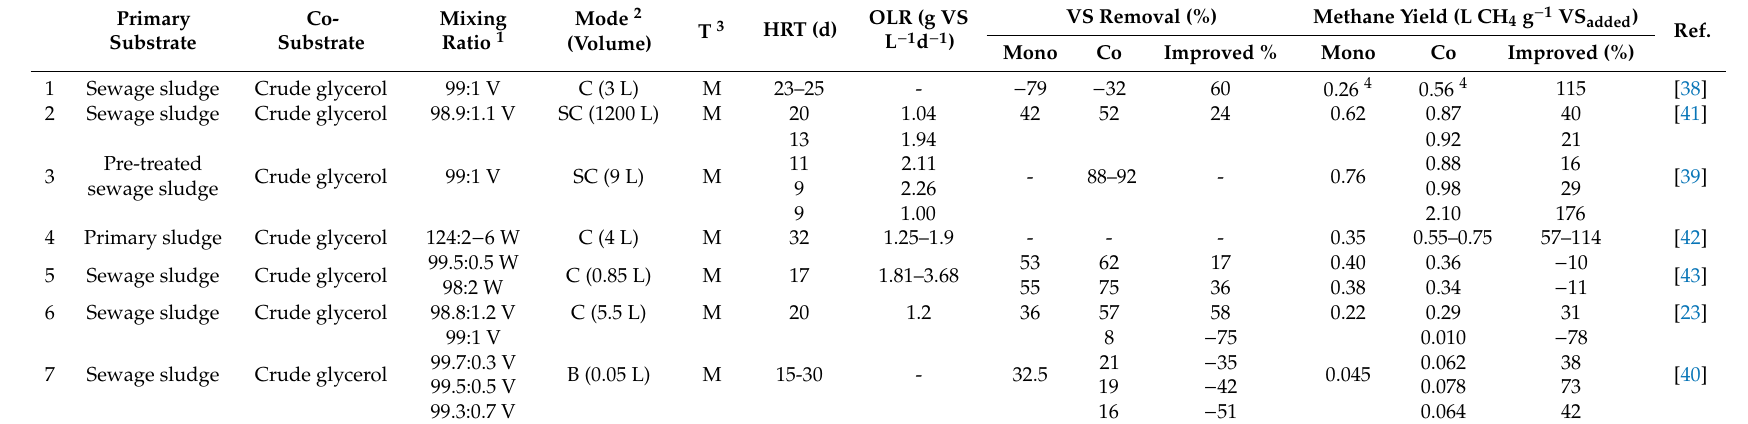
Table 3. Summary of studies using crude glycerol as a co-substrate in anaerobic co-digestion of wastewater